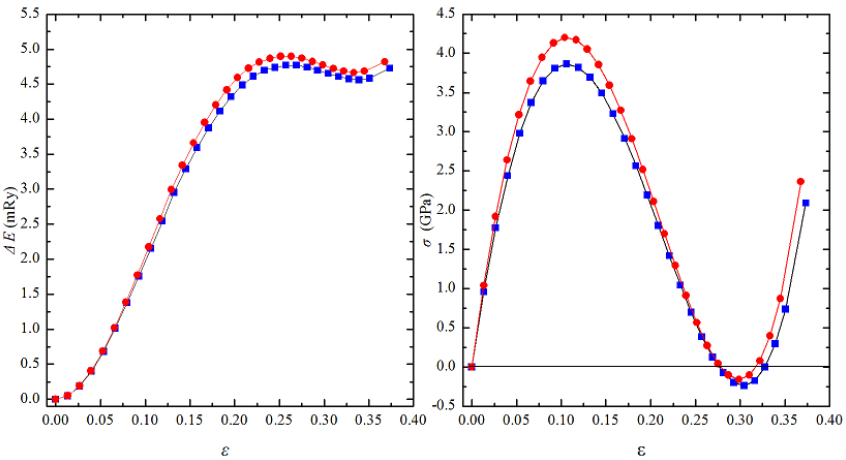
Figure 3. The energy difference Δ E and tensile stress σ as a function of tensile strain ε under <001> tensile loading for Al 0.4 Hf 0.6 NbTaTiZr. The rectangles stand for Δ E and σ of the relaxed structure, the cycles represent Δ E and σ of the unrelaxed